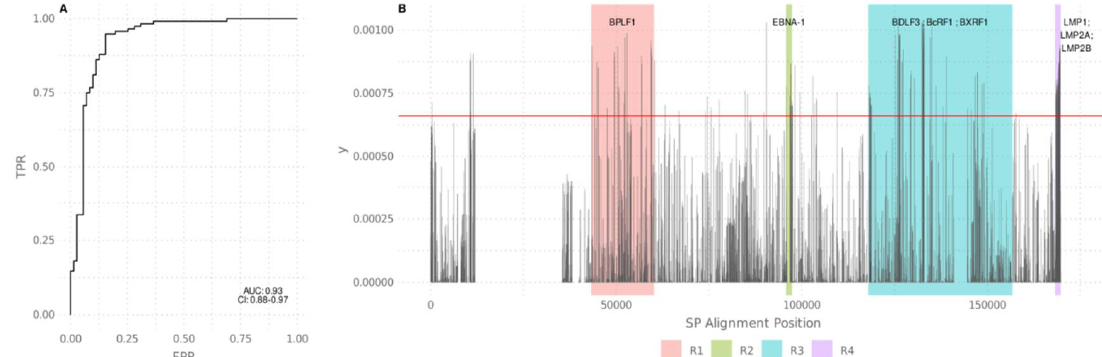
Figure 5. Discrimination analysis of principal components (DAPC): ( A ) ROC curve depicts the segregation potential of the sequences shown in Table 1; ( B ) DAPC variance contribution of each site (SNP) along the EBV1 genome. The red horizontal line indicates the threshold (0.00066) above which structural SNPs were identified. Colored boxes delimit the 4 informative coding regions of the genome. The most relevant genes within each region are indicated on the top of each box.